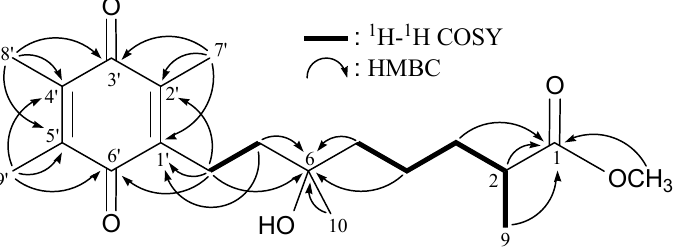
Figure 2. The 1 H– 1 H COSY and selective key HMBC correlations (protons → quaternary carbons) of 1